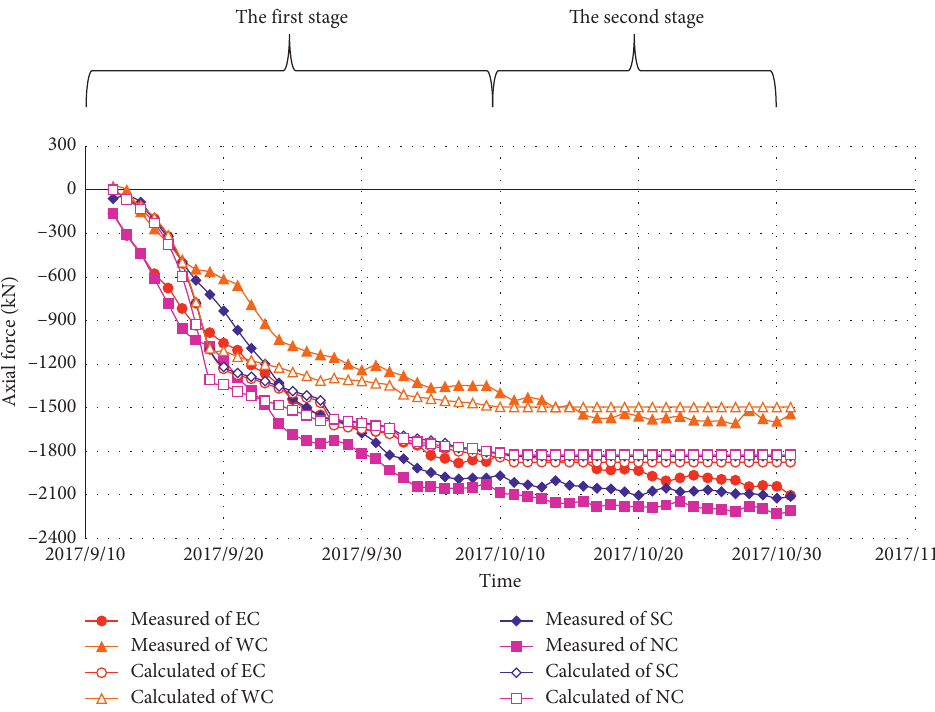
Figure 11: Plot of axial force versus time of each support column during construction